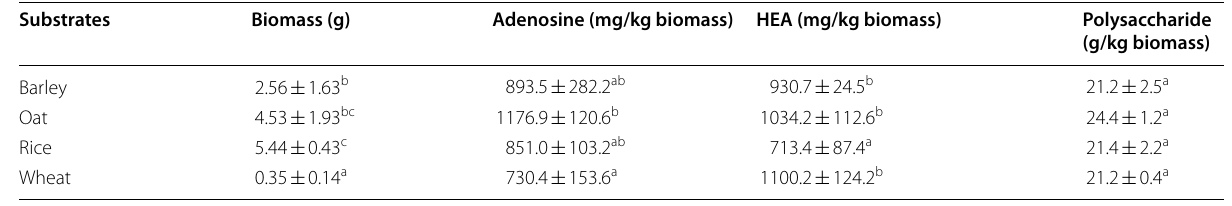
Table 1 The biomass and adenosine, HEA and polysaccharide concentration in solid-fermented C. cicadae NTTU 868 fruit bodies with different grain